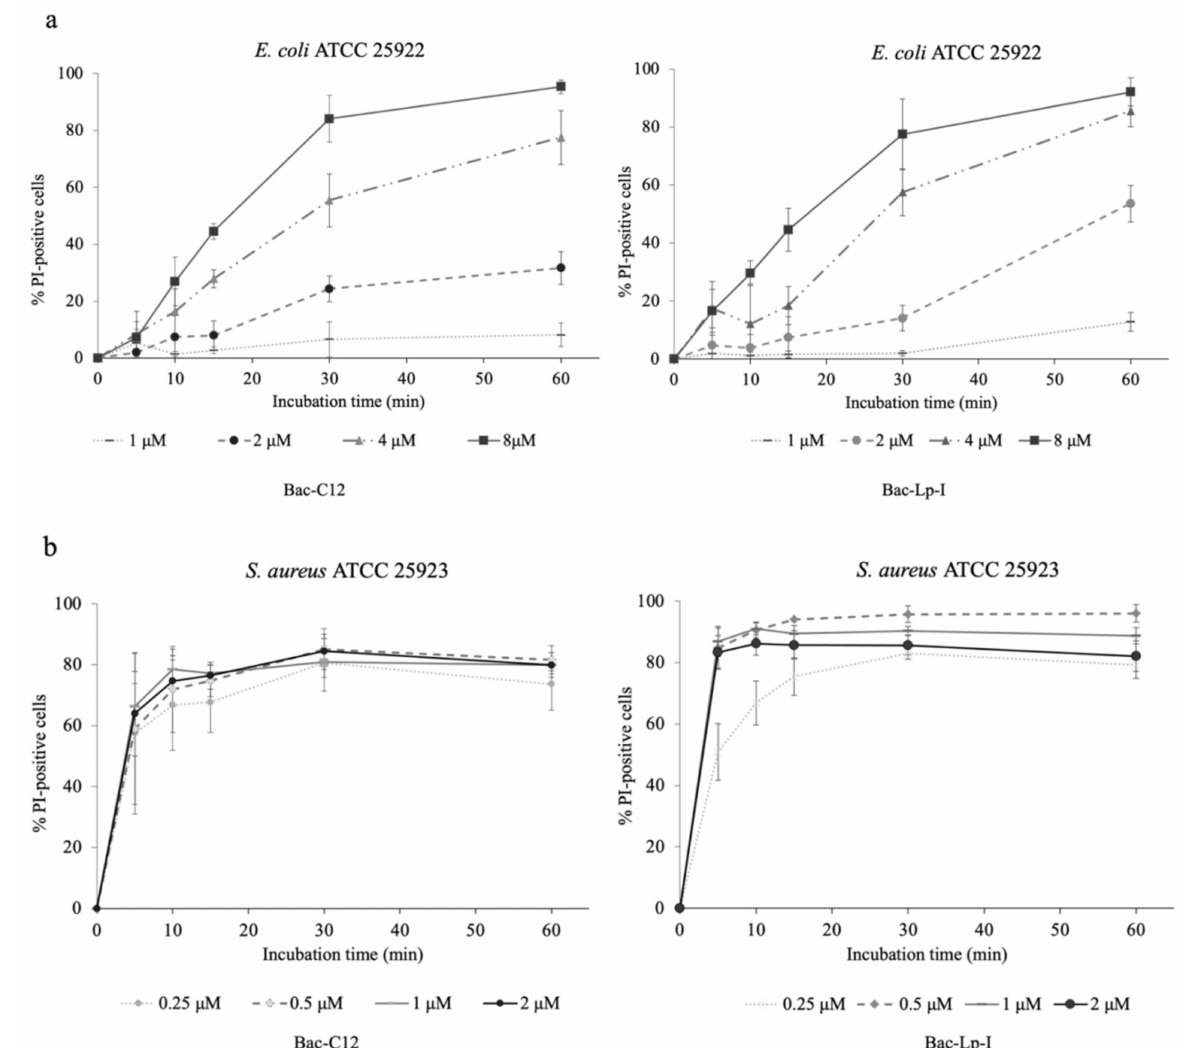
Figure 5. Membrane-damaging activity of Bac-C12 and Bac-Lp-I on E. coli ATCC 25922 ( a ) and S. aureus ATCC 25923 ( b ). The permeabilization assay with Bac-C12 and Bac-Lp-I has been performed in MHB. Bacterial cells were treated, for different incubation times, with indicated concentrations of peptide. % PI-positive: percentage of propidium iodide-positive cells. The background level of permeabilized cells, obtained with untreated samples, was always below 2% and was subtracted to the corresponding peptide-treated sample. Data are the mean ± SD of four independent